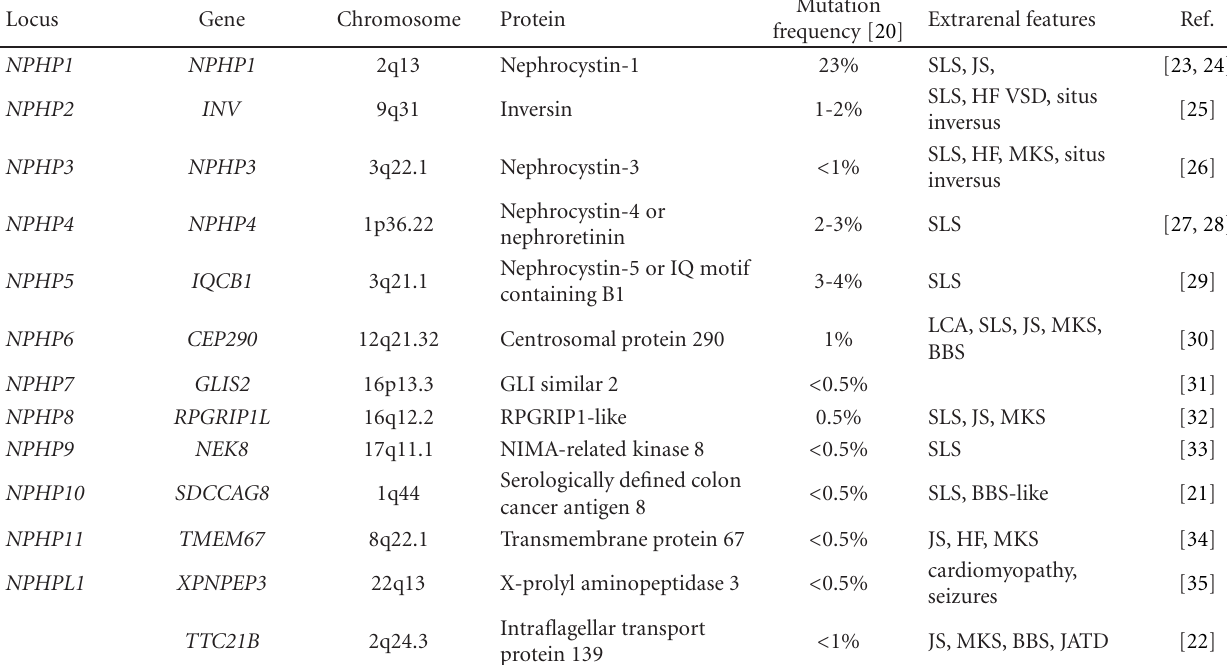
Table 1: Mutated genes in nephronophthisis and associated extrarenal manifestations. Locus Gene Chromosome Protein